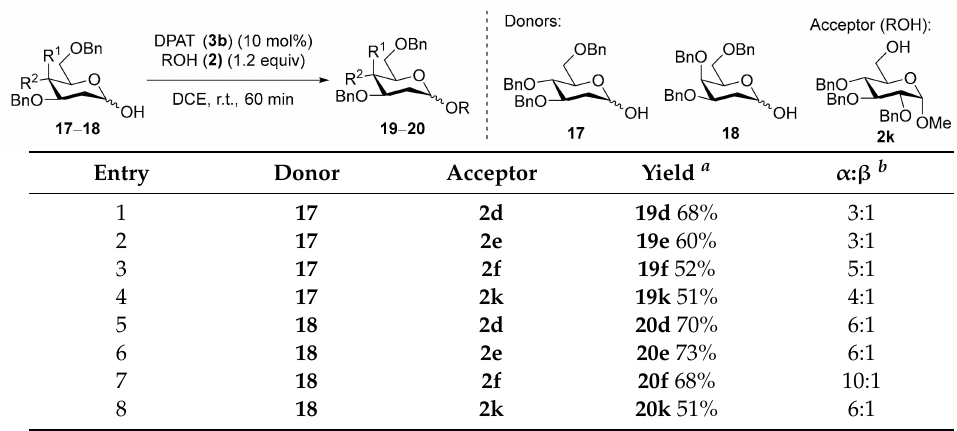
Table 5. Reaction scope of DPAT-catalyzed dehydrative glycosylation of